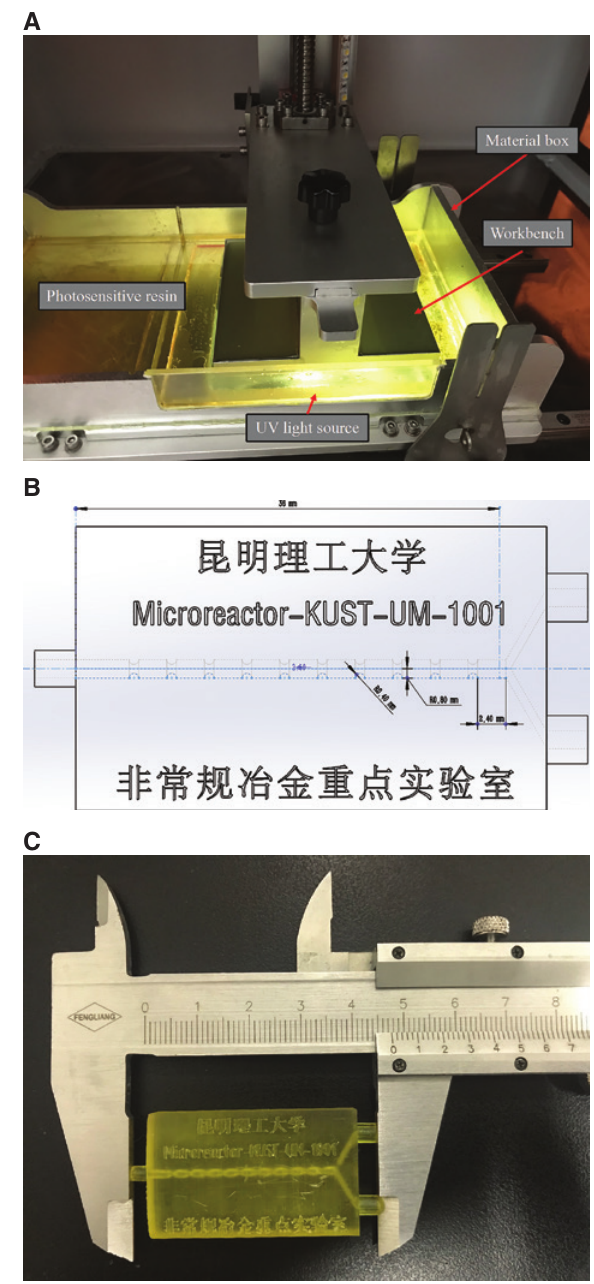
Figure 1: Physical diagram of the microreactor: (A) the physical diagram of key parts of the 3D printer, (B) 3D design diagram of the “Y”-shaped microreactor, (C) practical picture of the “Y”-shaped